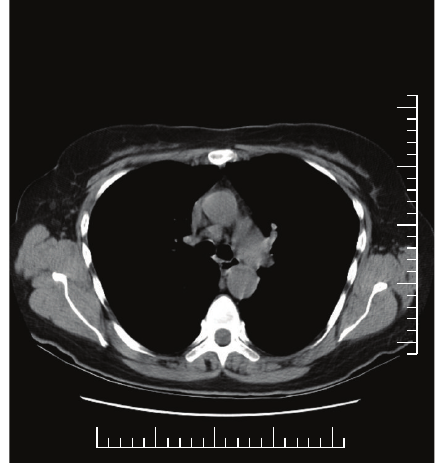
Figure 3: CT Chest showing mediastinal lymphadenopathy.